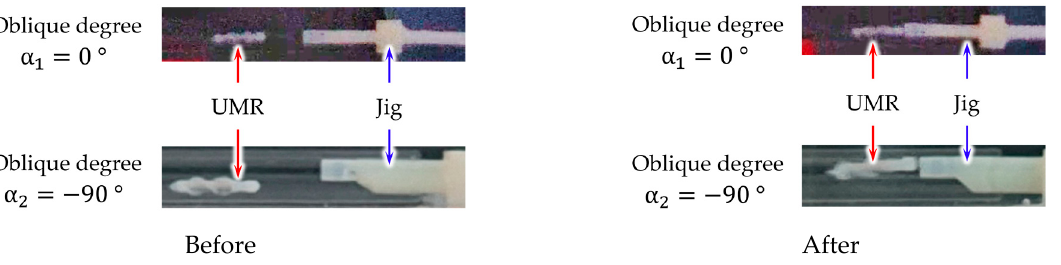
( a ) ( b ) Figure 13. ( a ) Success rate of recombination of the UMR with the delivery catheter without applying magnetic force; ( b ) with applying magnetic force. 3.2. In Vivo Experiment